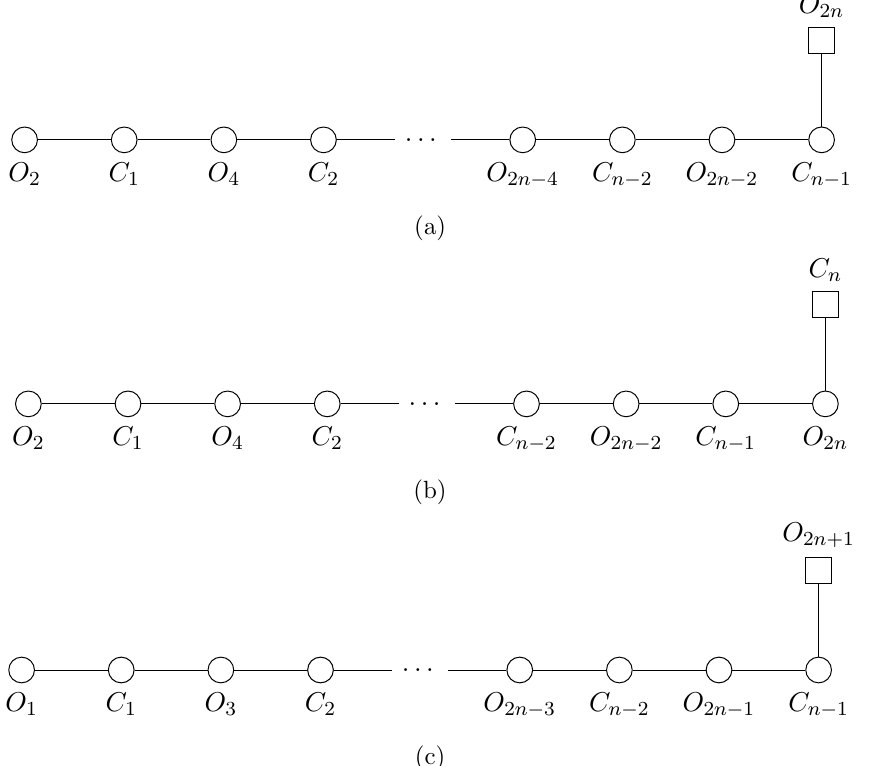
Figure 62. Quivers whose Higgs branch is the maximal nilpotent orbit of the algebras: (a) so (2 n ), (b) sp ( n ) and (c) so (2 n +